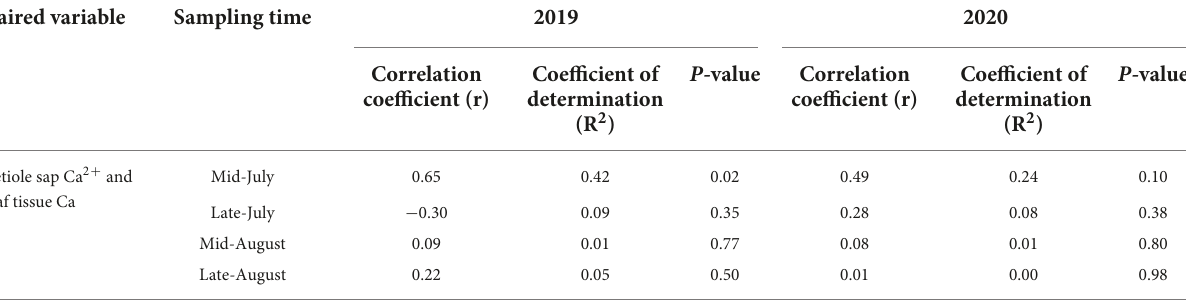
TABLE 7 Pearson correlation coefficients (r), linear regression coefficients of determination (R 2 ), and P -values of paired variables by sampling time point in 2019 and 2020. Paired variable